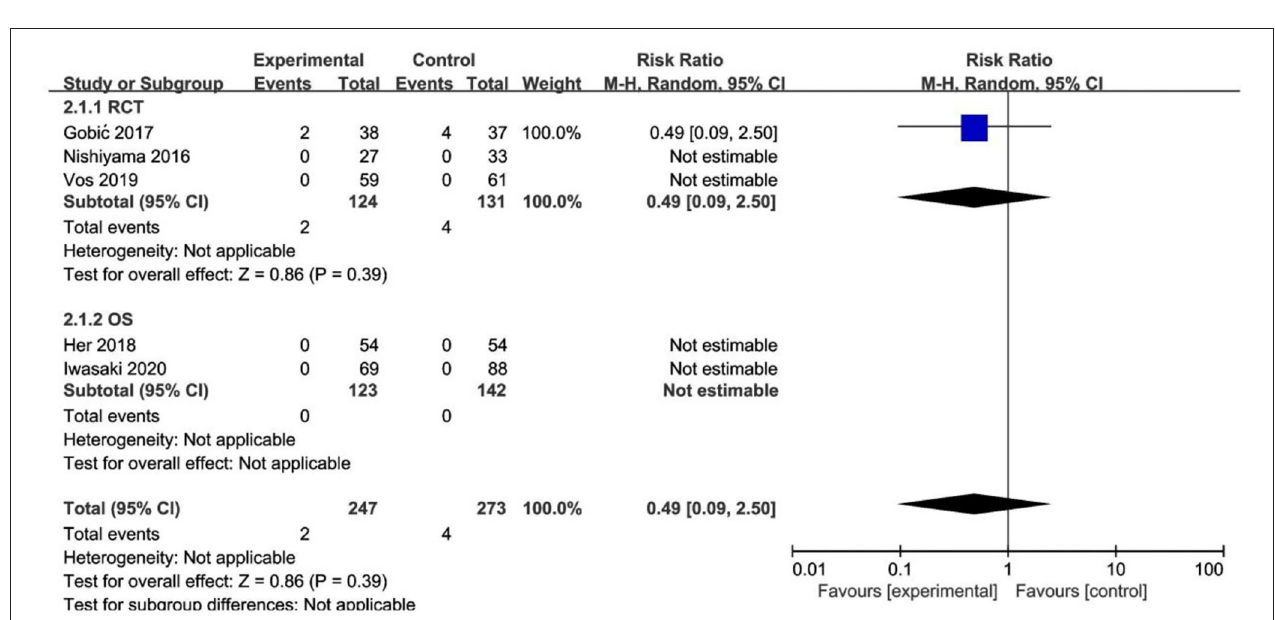
FIGURE 4 | Meta-analysis of the effects of DCB compared with control in CD.